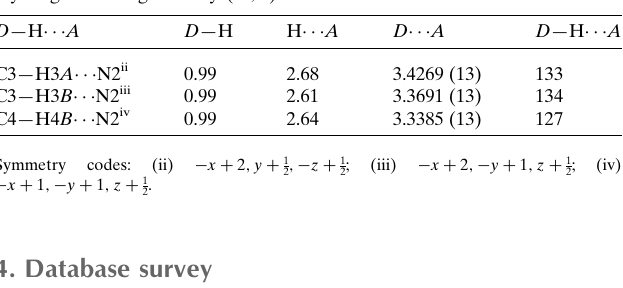
Table 4 Hydrogen-bond geometry (A˚ , (cid:2) ) for 2 .